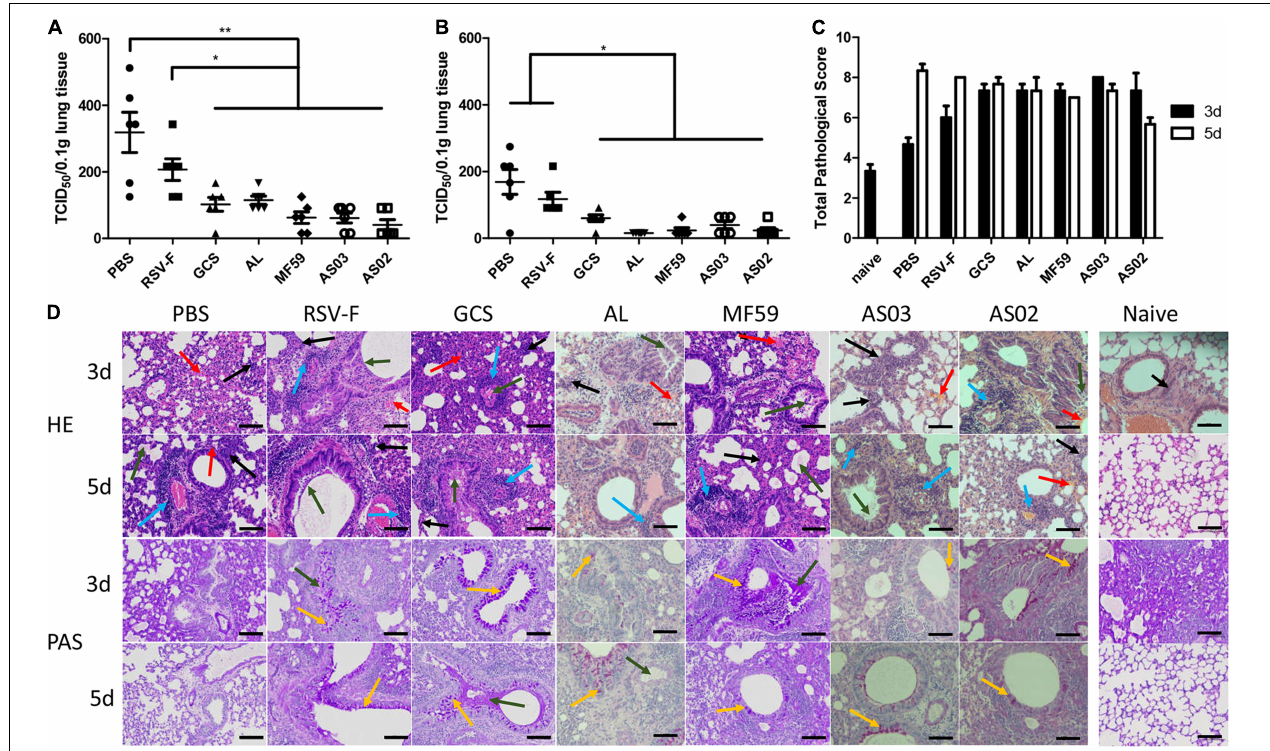
FIGURE 6 | Pulmonary viral loads in lung tissue of immunized mice at day 3 (A) and 5 (B) after intranasal challenge with RSV/A/long virus. Results are shown as mean ± SD of viral loads calculated from all six mice in each group. Units: TCID 50 /0.1g lung tissue. * P < 0.05, ** P < 0.01 between two different groups. Pulmonary pathology scores were calculated according to criteria listed in section “Histopathology” (C) . Naive group pathology images were only collected at day 3. Data is shown as mean ± SD of scores calculated from all six mice in each group. Representative HPE and PAS stained mouse lungs at 20 × magnification are shown (D) . Lung tissue infiltration of lymphocytes and neutrophils (black arrow), perivascular cuffing formed by inflammatory cell infiltration around the local vessels (blue arrow), local bleeding (red arrow), exudation of eosinophilic serous substance in alveolar cavity (green arrow), and bronchial beaker cell (yellow arrow) are marked. Scale bar (black line): 100 µ